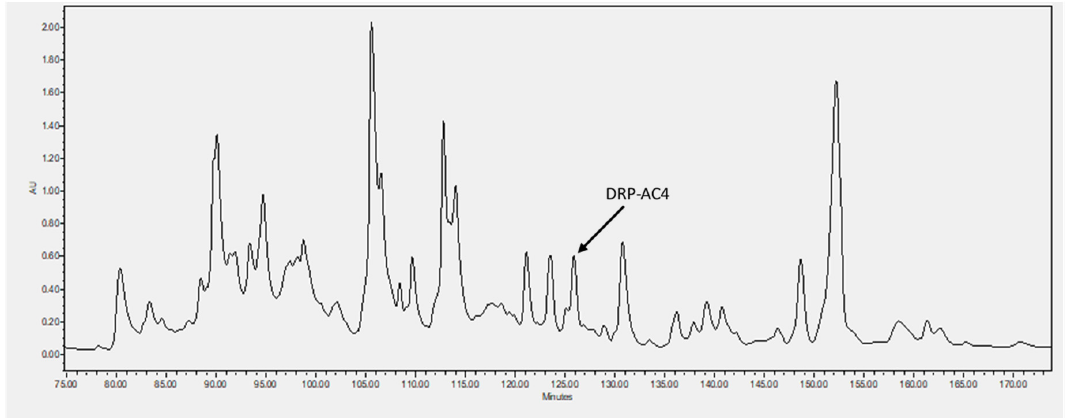
Figure 3. Reverse-phase HPLC chromatogram of Agalychnis callidryas skin secretion indicating elution/retention time of DRP-AC4 at 126 min (arrow). The Y-axis indicates absorbance units at λ = 214 nm.